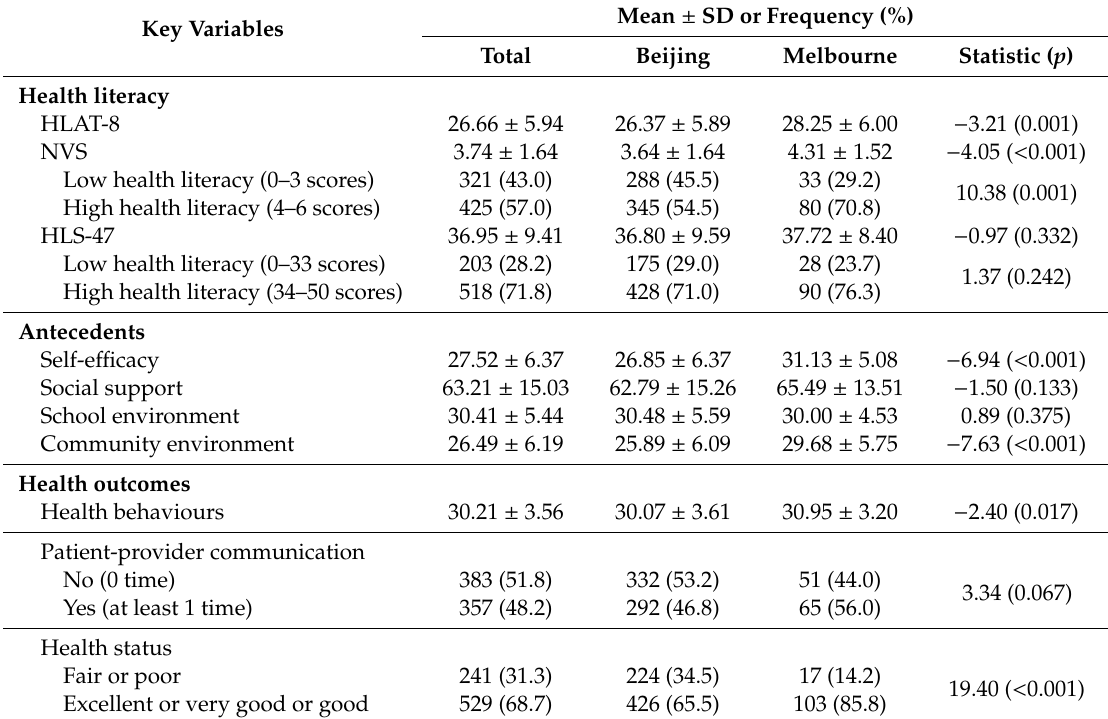
Table 2. Distribution and univariate analysis of health literacy, its antecedents and health